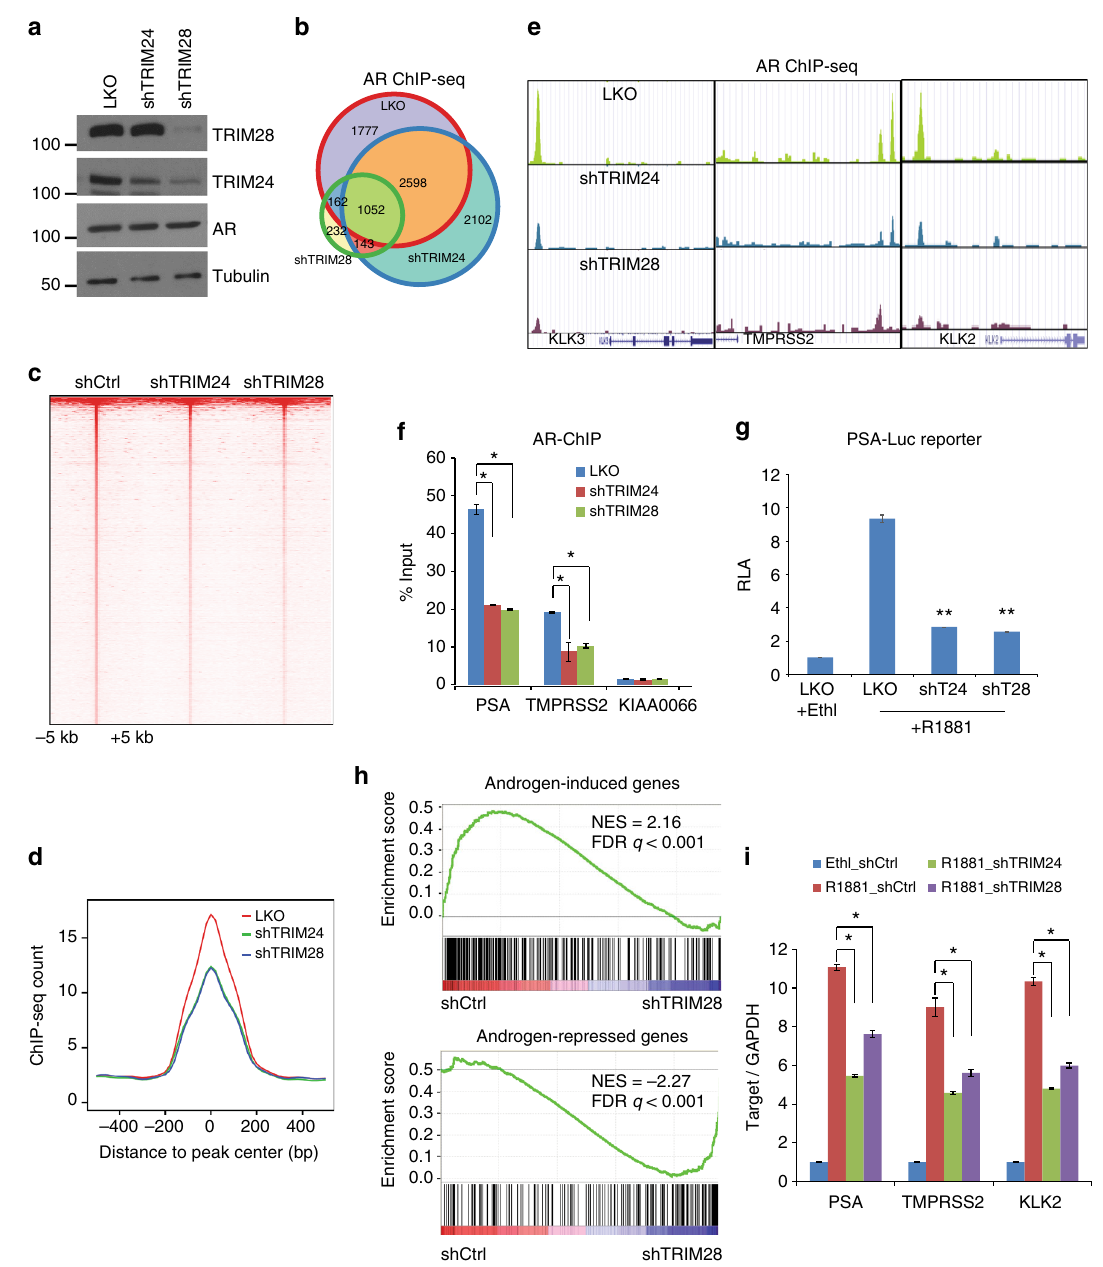
Fig. 5 TRIM28 enhances AR signaling in prostate cancer. a Western blot analysis of protein lysates of LNCaP cells treated with pLKO, shTRIM24, or shTRIM28 with indicated antibodies. b – e AR ChIP-seq was performed in control, TRIM24-, or TRIM28-knockdown LNCaP cells. Venn diagram ( b ) shows the overlap of AR binding sites in these cells, where heatmap ( c ) and intensity plots ( d ) depict AR ChIP-seq read intensity across all three samples centered (± 5 kb) at AR binding sites found in control LNCaP cells. AR ChIP-seq signals at several known AR-target genes are shown using UCSC Genome Browser Tracks ( e ). f ChIP-qPCR showing AR enrichment at the PSA and TMPRSS2 enhancers. KIAA0066 was used as negative control. Data shown is mean (± SEM, n = 3). * P < 0.05 by Student ’ s t -test. g TRIM28 is required for AR transactivation activity. A luciferase reporter construct consisted of PSA enhancer and promoter elements were transfected into pLKO, shTRIM24, and shTRIM28 LNCaP cells. Relative luciferase activities are presented as mean (± SEM, n = 3). ** P < 0.01 by Student ’ s t -test. h TRIM28 positively regulates AR-mediated gene expression program. GSEA was performed to determine the enrichment of AR-induced (upper panel) or -repressed gene set (lower panel) in gene expression dataset pro fi ling control and TRIM28-knockdown LNCaP cells grown in the presence of androgen. i TRIM28 is required for AR-regulated gene expression. LNCaP cells with pLKO, shTRIM24, and shTRIM28 were hormone-starved for 3 days, treated with 1 nM R1881 for 48 h, and subjected to qRT-PCR analysis in comparison to a control LNCaP cells treated with ethanol (Ethl). Data were normalized to GAPDH. Data shown is mean (± SEM, n = 3). * P < 0.05 by Student ’ s t multiple PCa datasets with clinical information 46,47 , we found that patients with high levels of TRIM28 showed signi fi cantly reduced chances of overall survival, suggesting a prognostic potential of TRIM28 (Supplementary Fig. 6a, b).